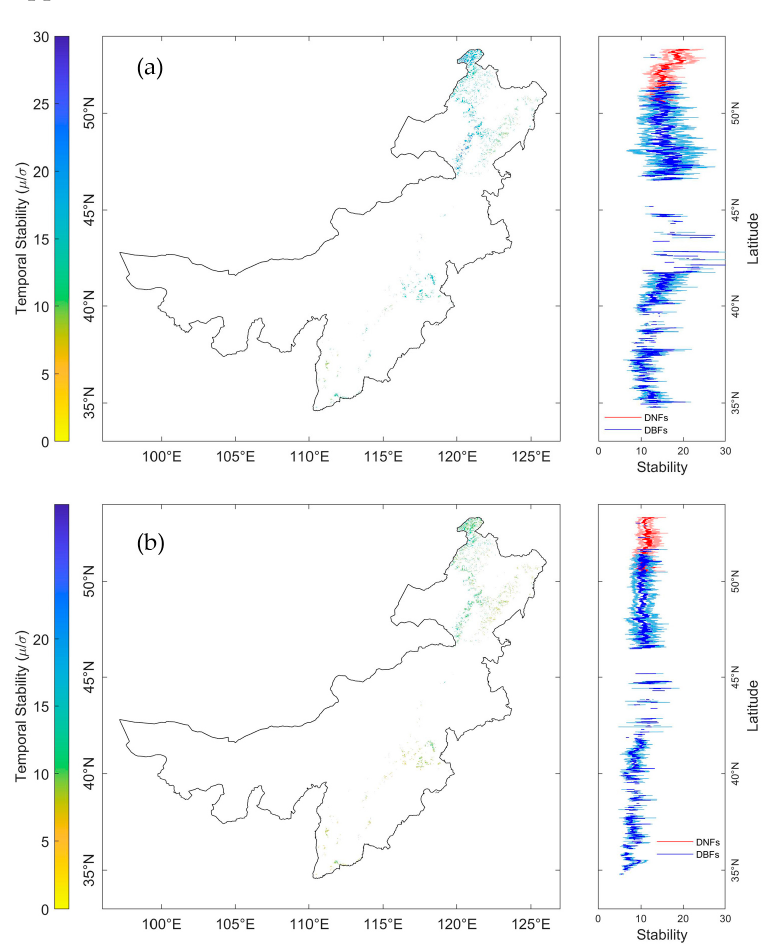
Figure A1. Spatial distribution of ( a ) TS EVI and ( b ) TS GPP during 2001–2018. The panels on the left are the spatial distributions of the temporal stability calculated from each pixel, while the panels on the right are the mean ± std of the latitudinal values of the DNFs (red lines) and DBFs (blue lines).